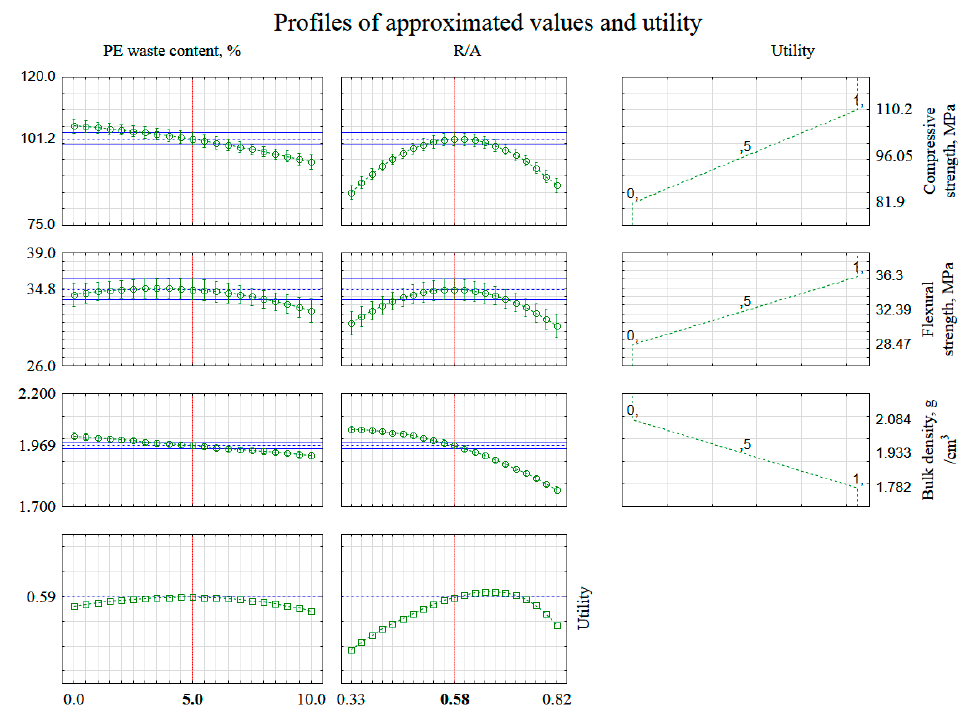
Figure 17. Profiles of approximated values and utility for the method of general function optimization. Optimum value of flexural and compressive strength and volumetric density were obtained for the percentage of PE waste addition at 5 vol.% and resin to aggregate ratio (R/A) equals 0.58. The values of compressive strength, flexural strength, and volumetric density at the point of maximum utility are 101.2 MPa, 34.8 MPa, and 1.969 g/cm 3 , respec- tively. The total utility index reached 0.59, confirming the relatively close location of critical points for all three output variables. The spatial and contour plot of total utility is shown in Figure 18.